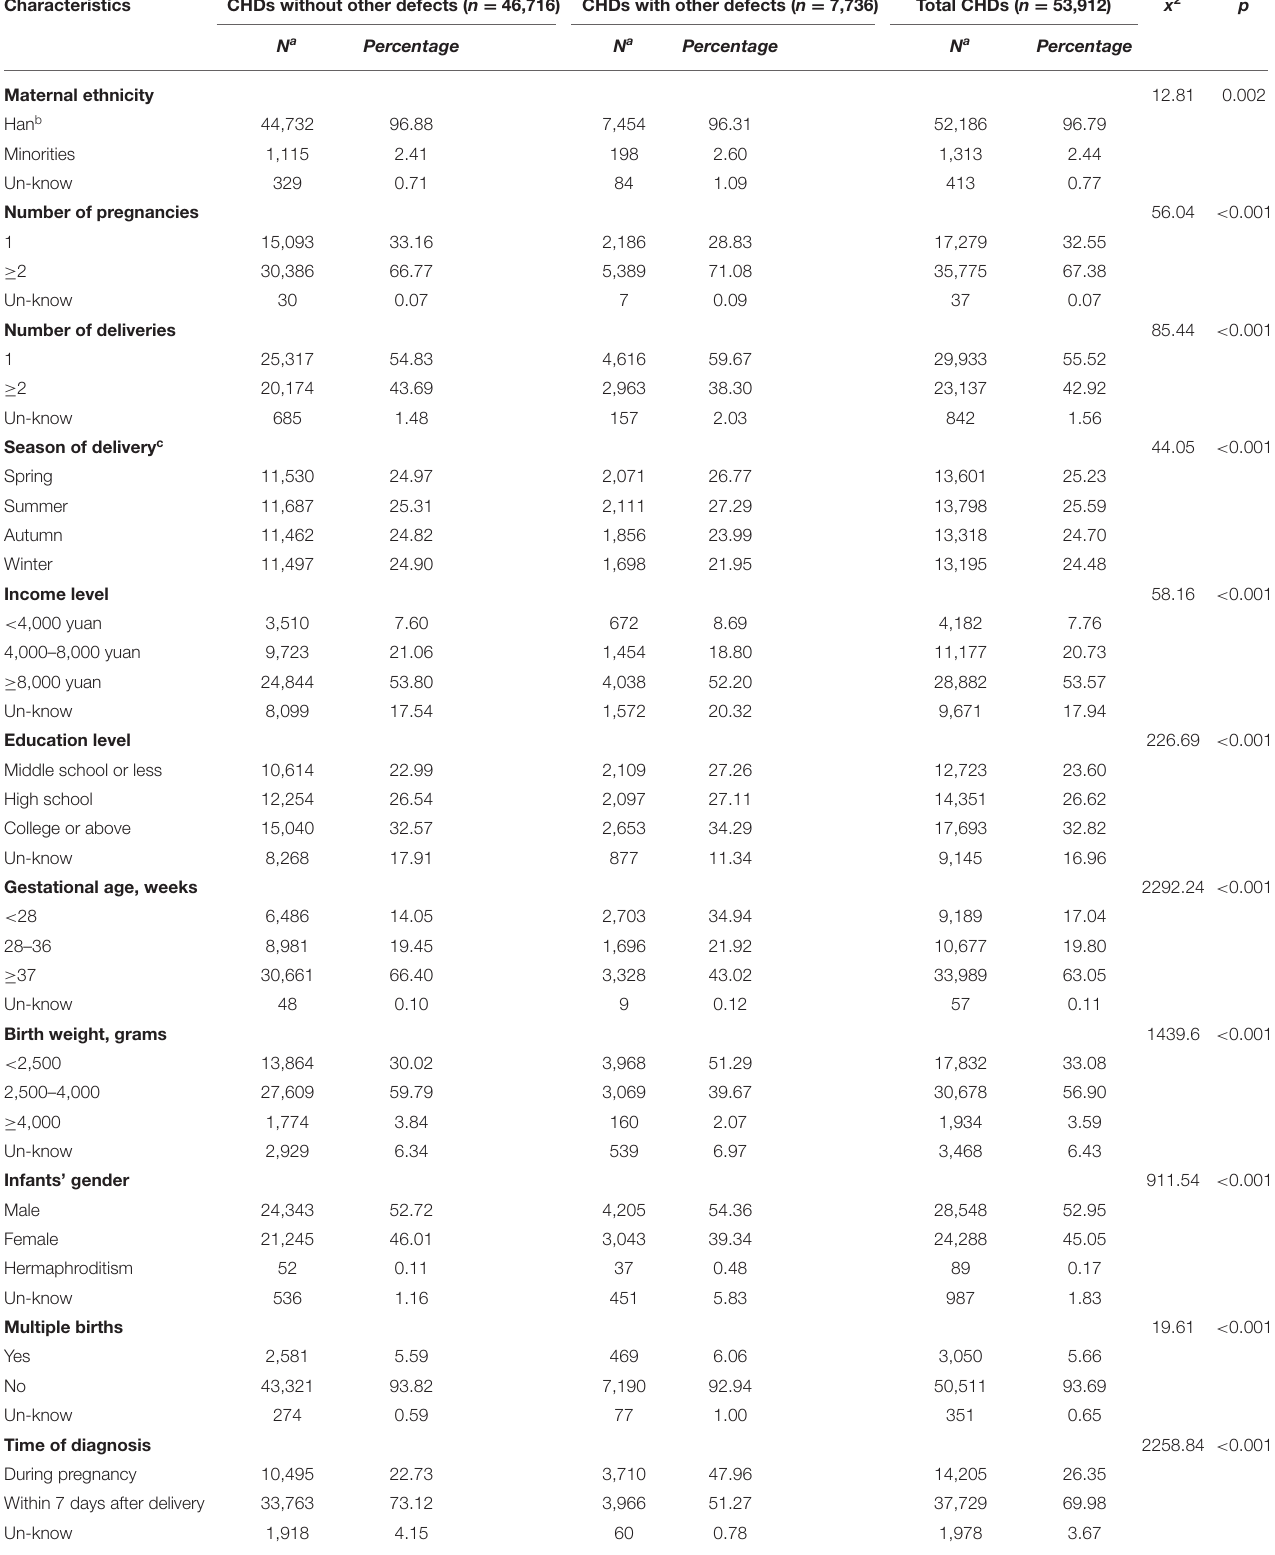
TABLE 2 | Percentage of congenital heart defects (CHDs) across different stratifications separated by characteristics of mothers and infants.